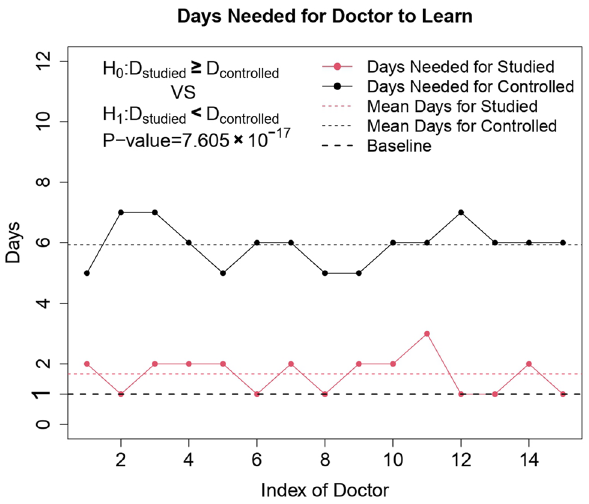
Figure 4. Training curves of primary care